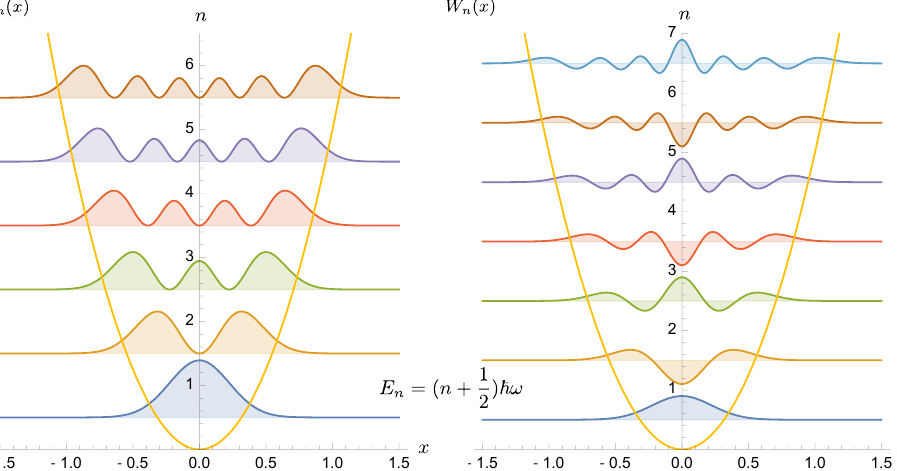
Figure 3. Comparison of the probability distribution P n ( x ) and the Wigner function W n ( x , p = 0 ) of a harmonic oscillator from the ground state up to 5 th excited state. A few distinguished features of the Wigner function can be easily identified, such as W n ( 0 ) = the Wigner function is negative. Both exhibit exponential decay into the classically forbidden